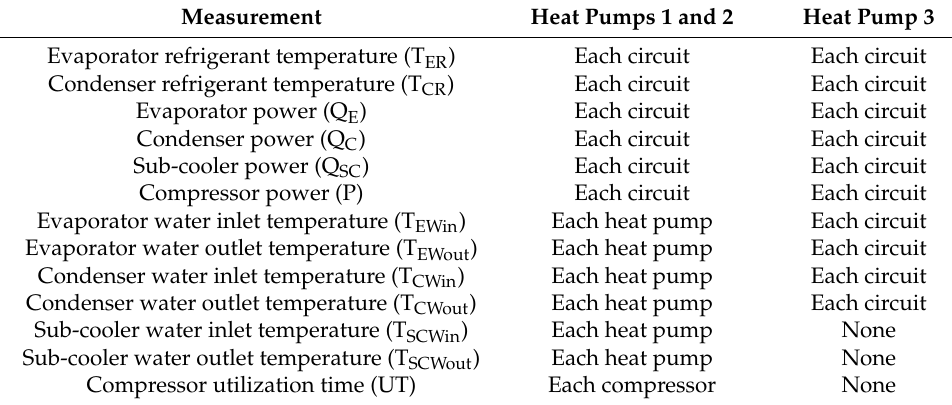
Table 1. List of measured